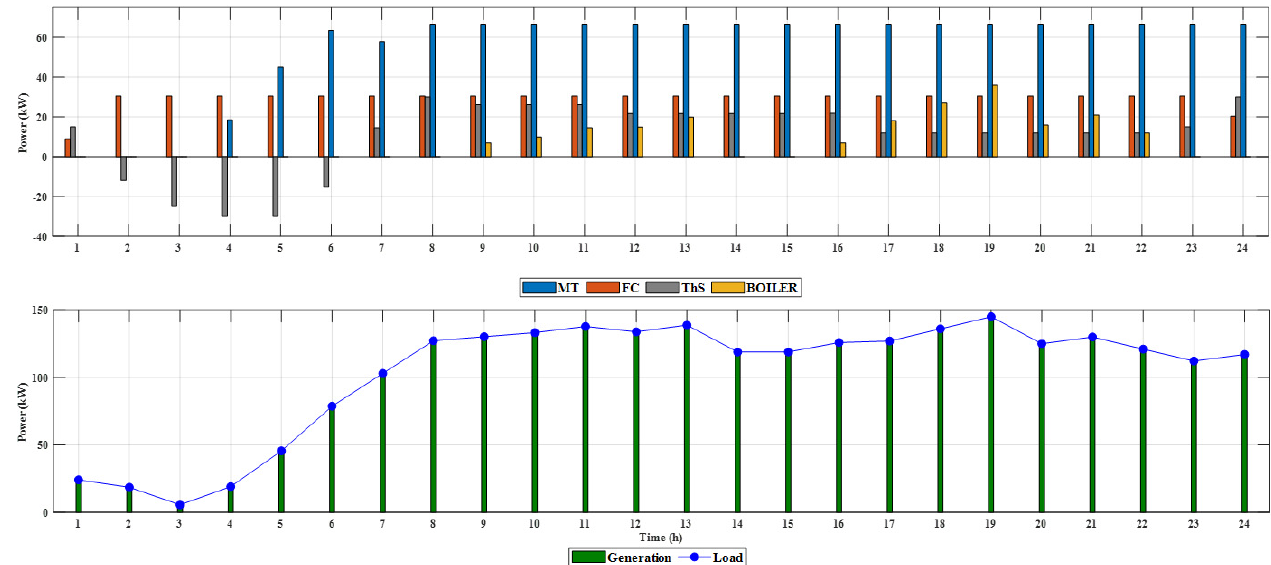
Figure 9. Optimal management of thermal elements of the micro-grid. Table 2. Results of the proposed MCS-based method and centralized method.